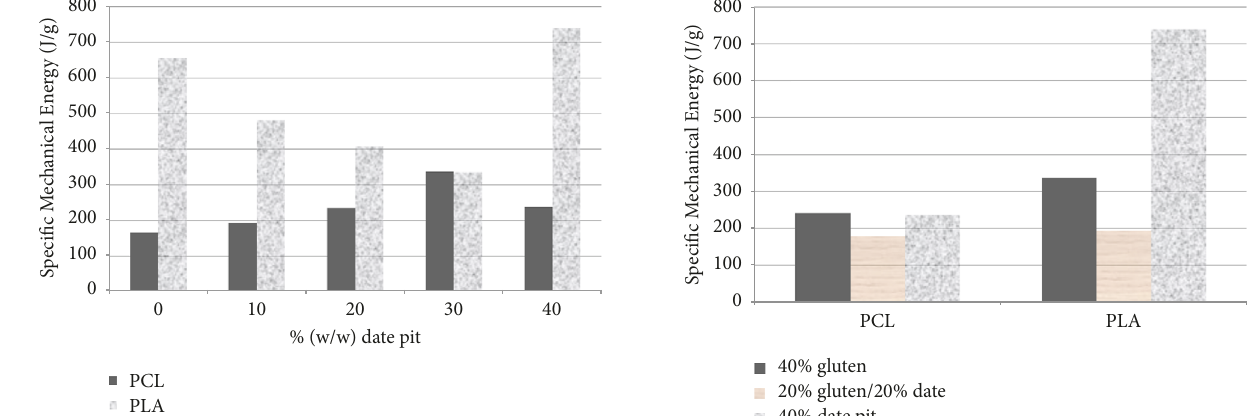
Figure 2: Specific mechanical energy during extrusion for PCL and PLA composites with gluten and date